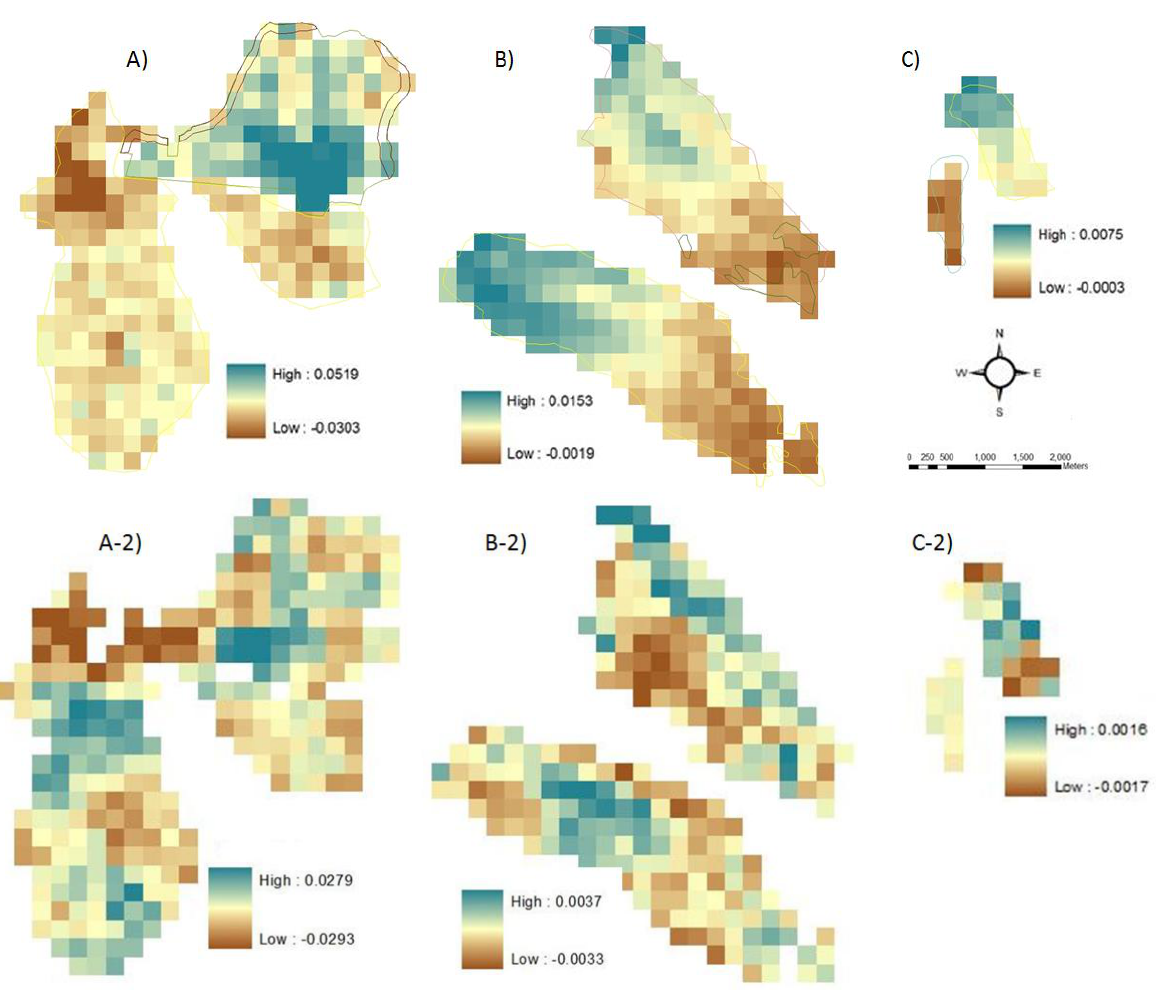
Figure 7. The MLR spatial interpretation for the model results for trends in monsoon NDVI are shown in Frijoles Canyon ( A ), Mid Elevation Mesas ( B ) and Capulin ( C ) fires. The figures A-2, B-2 and C-2 show the difference of the values estimated for